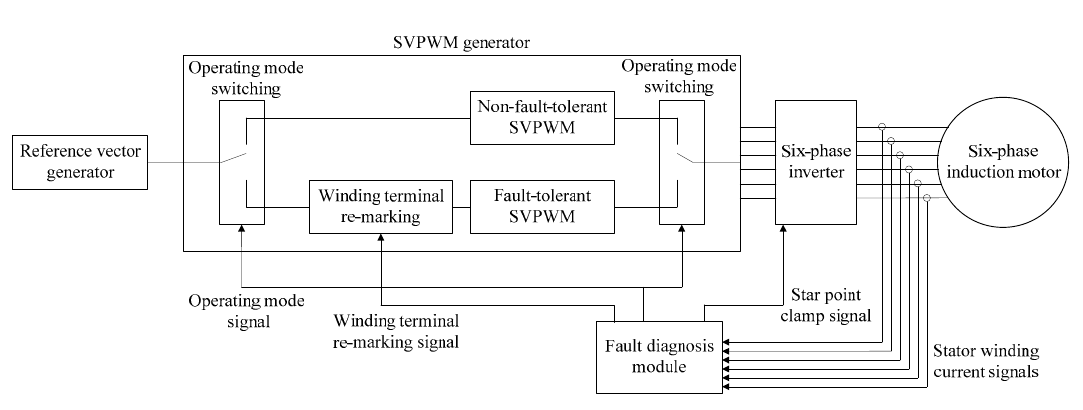
Figure 2. Schematic diagram of SVPWM control structure.